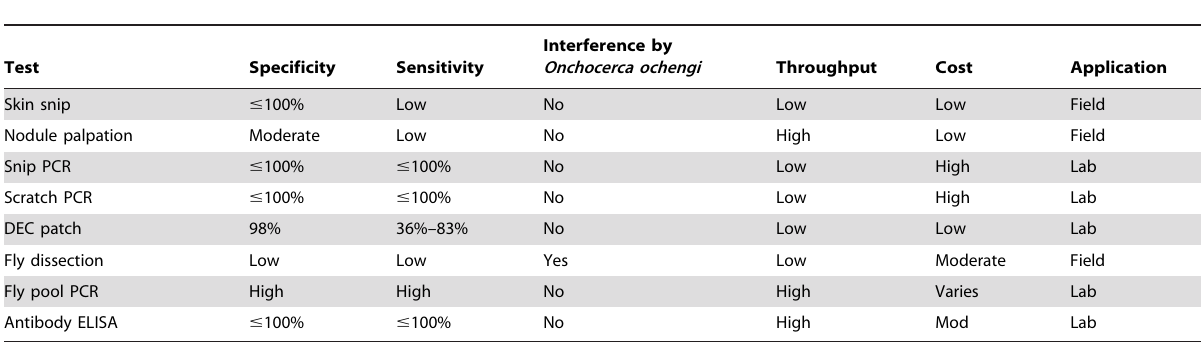
Table 4. A Comparison of Current Diagnostic Tests for Human